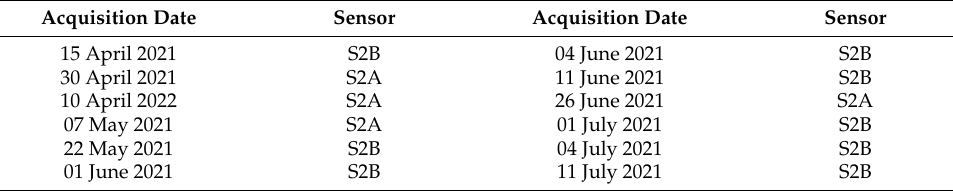
Table 5. Sentinel-2 images (tile T33TVF) considered in this study.